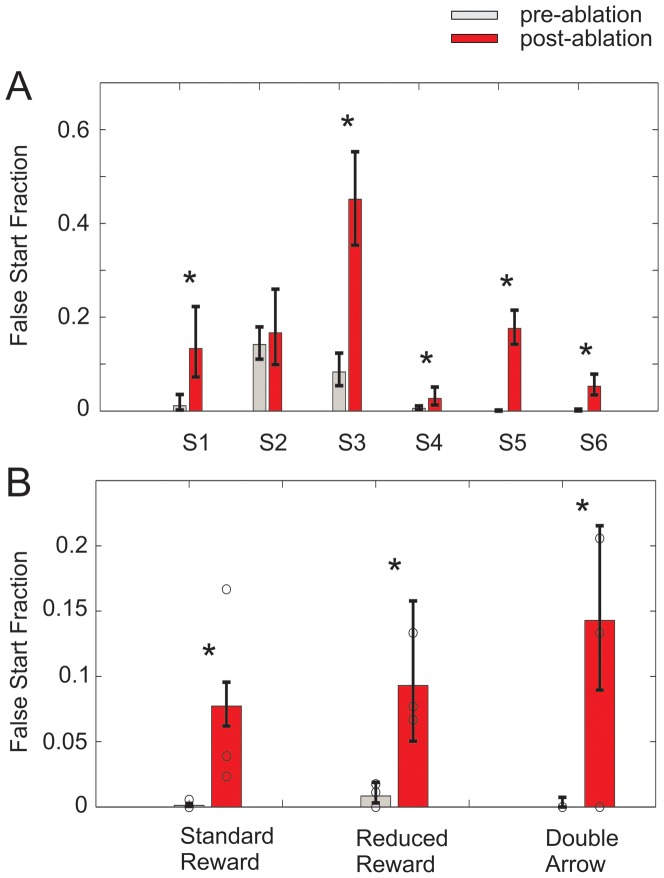
Fraction of premature responses before (gray) and after (red) bilateral dACC ablation.(A) False start fractions in six patients for the simple reaction time task (S1–S3) and the reward-dependent decision making task (S4–S6). (B) False start fractions in the three conditions of the reward-dependent decision making task, grouping across patients (S4–S6). Circles mark individual false start fractions for S4–S6. In both panels, asterisks indicate p<0.05, and error bars indicate 66% confidence intervals, analogous to standard error of the mean (standard error bars). For bars in panel A, proceeding from left to right, N = 90, 30, 120, 30, 84, 31, 533, 112, 816, 125, 805, 133. For bars in panel B, proceeding from left to right, N = 1676, 285, 239, 43, 239, 4.